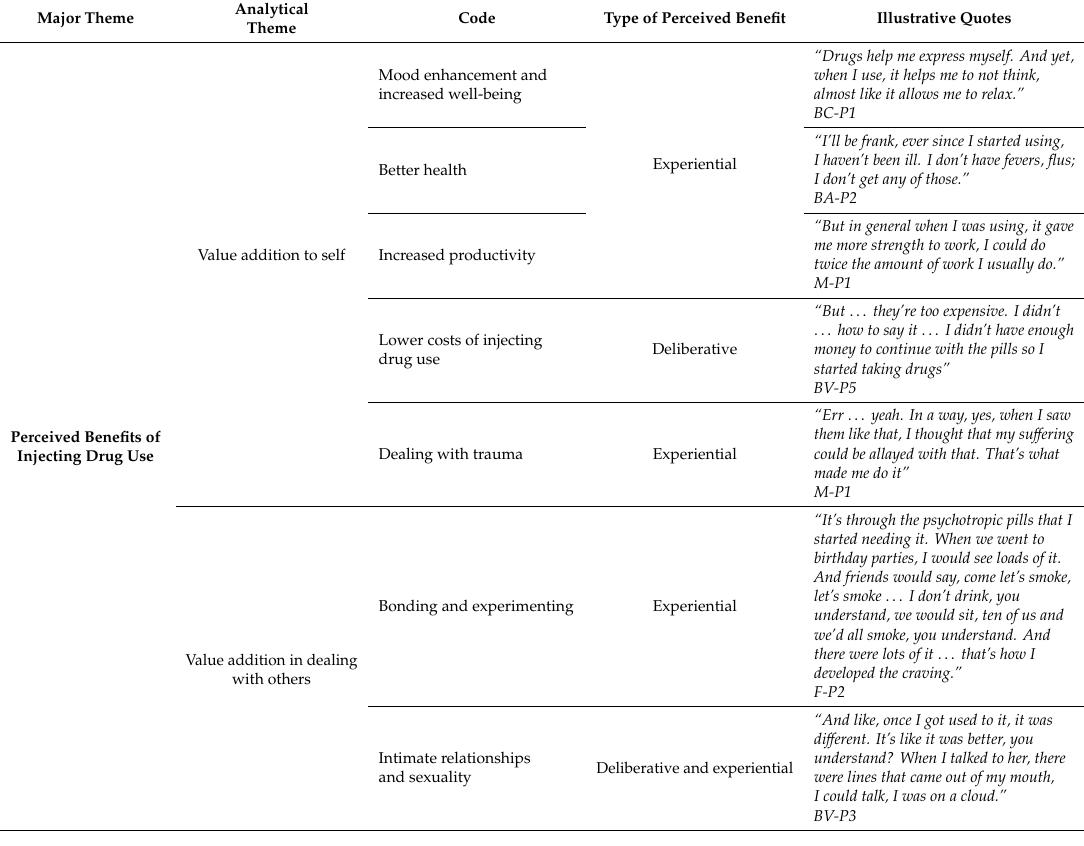
Table 4. Perceived benefits of Heroin use among heroin